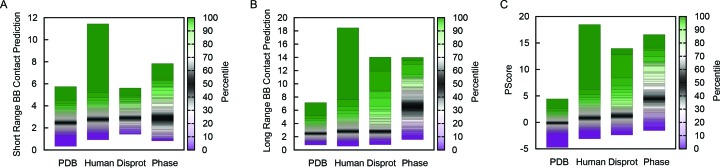
Comparison of scores used in generating phase separation predictions.(A) Highest number of short-range backbone contacts predicted, by window, for the PDB test set, the human proteome, the set of disordered human proteins from Disprot, and the full phase separation test set (N = 121), where percentile ranges are shown in colored boxes. (B) Highest number of long-range backbone contacts predicted, as for panel a. (C) Results for the final predictor plotted with the predictor’s phase separation propensity scores (PScore). Prediction of long-range backbone contacts provides the majority of the discrimination seen in the final predictor.